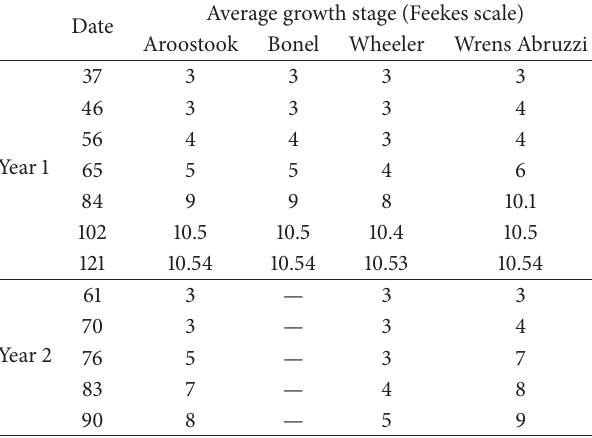
Table 2: Average growth stage (Feekes scale [39]) of different rye varieties observed at successive sampling dates during the first and second year of experiments (“Bonel” not used in the second